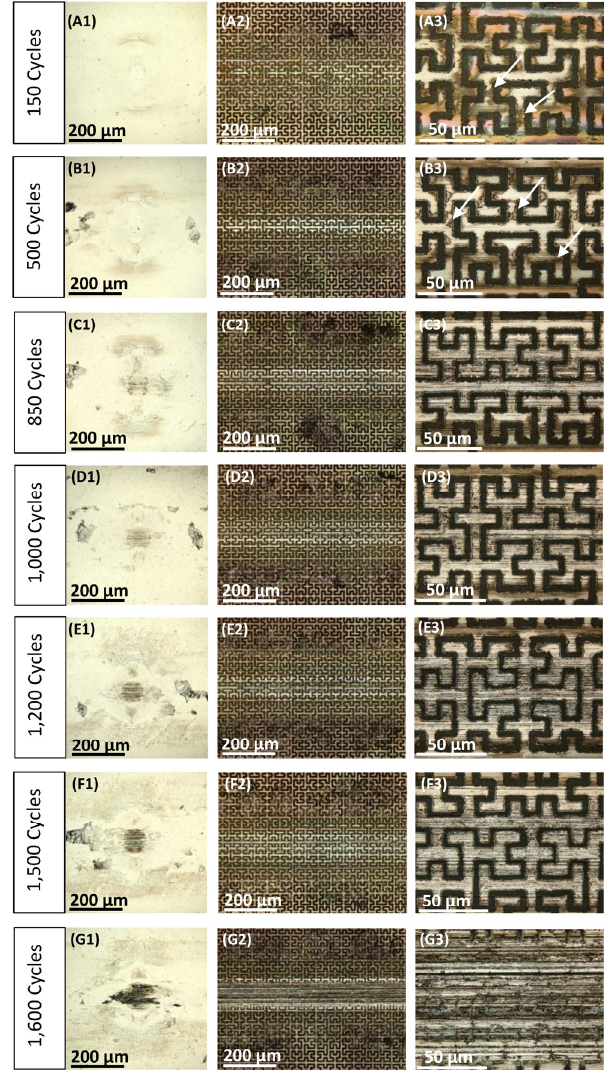
Fig. 14 Optical Images of the counterface balls and wear tracks: (A1)–(G1) counterface balls, and (A2)–(G2) wear tracks after progressive tests on the PDA/PTFE coatings on laser textured stainless steel. (A3)–(G3) are zoom-in images of (A2)–(G2). The arrows in (A2) and (A3) point to small amounts of PTFE residue inside the wear track. The arrows in (A3) and (B3) point to the PTFE coating transferred from inside the textured grooves to the worn top surface of the wear